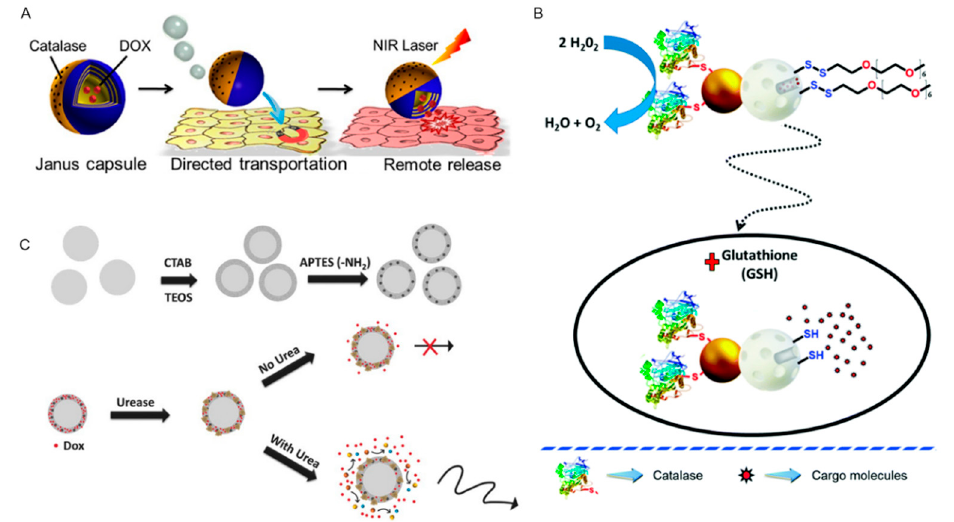
Figure 3. Self-propelling nanorobots by transforming chemical reaction energy into motion force. ( A )